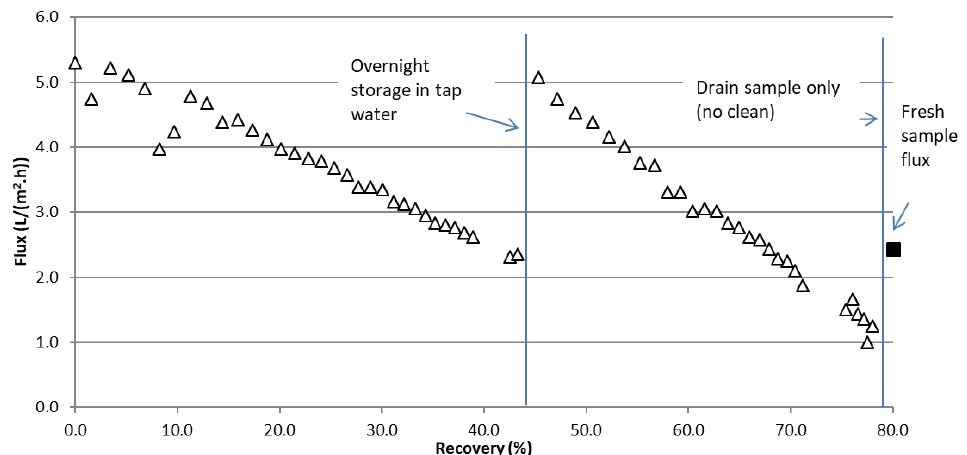
Figure 3. Flux during extended run on FStW using the PU-PTFE membrane as a function of water recovered from the initial sample. The solid square at end of the run is the flux when fresh sample was reloaded into the feed container.